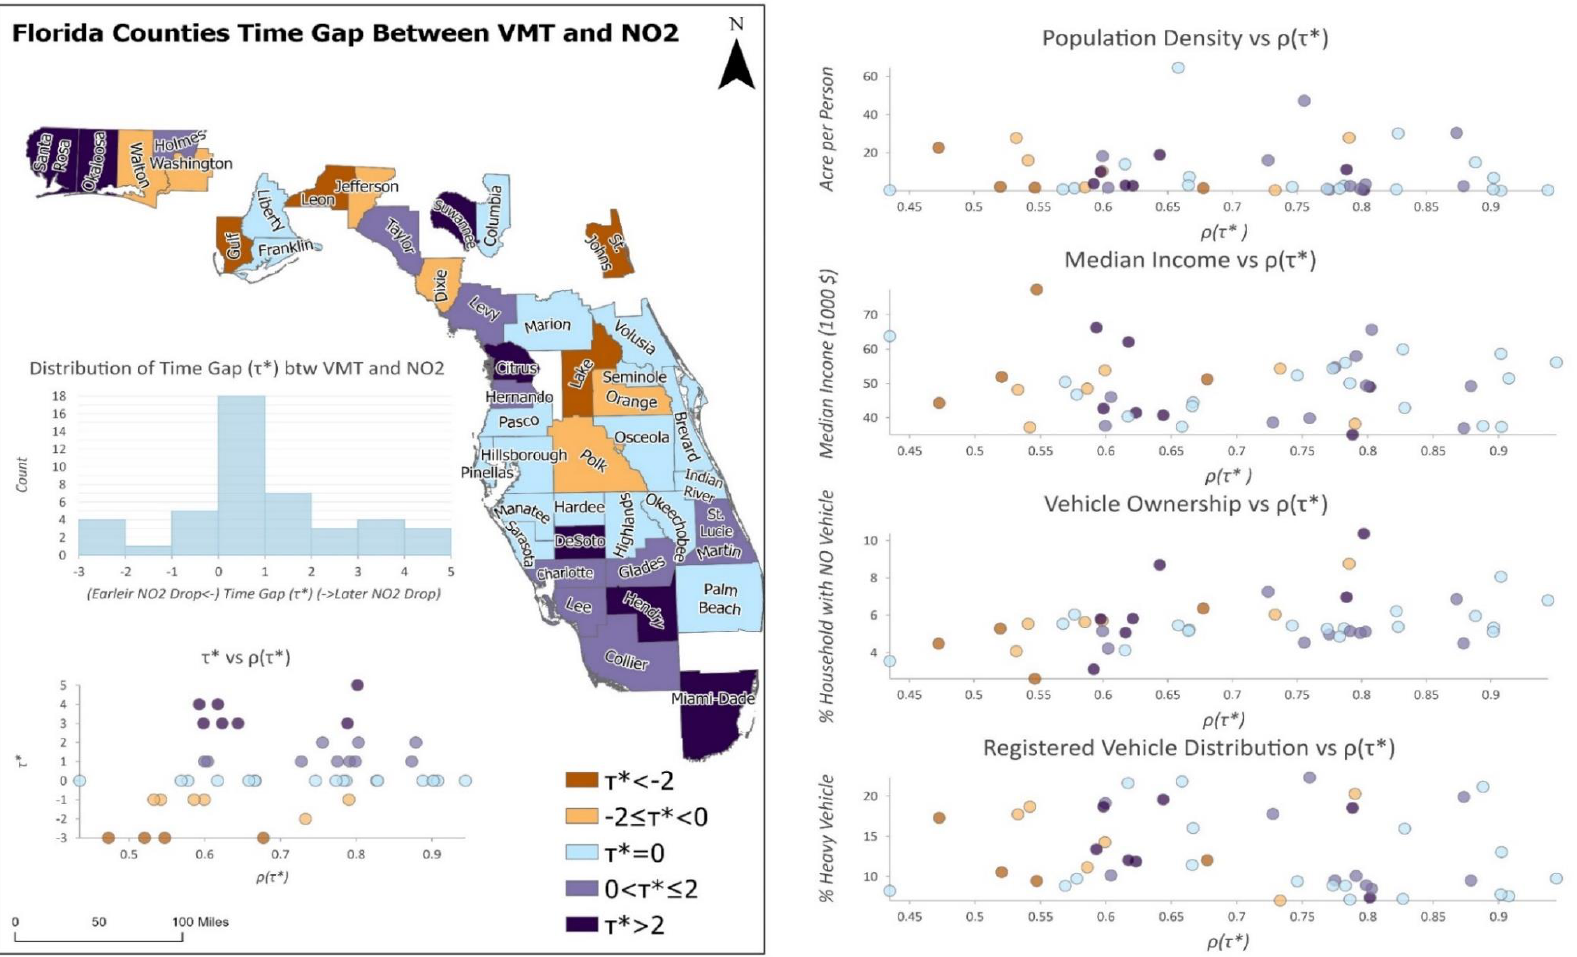
Figure 9. Distribution of the time lag between VMT and NO 2 concentration among Florida counties and potential factors that can affect the correlation between VMT and NO 2 concentration.